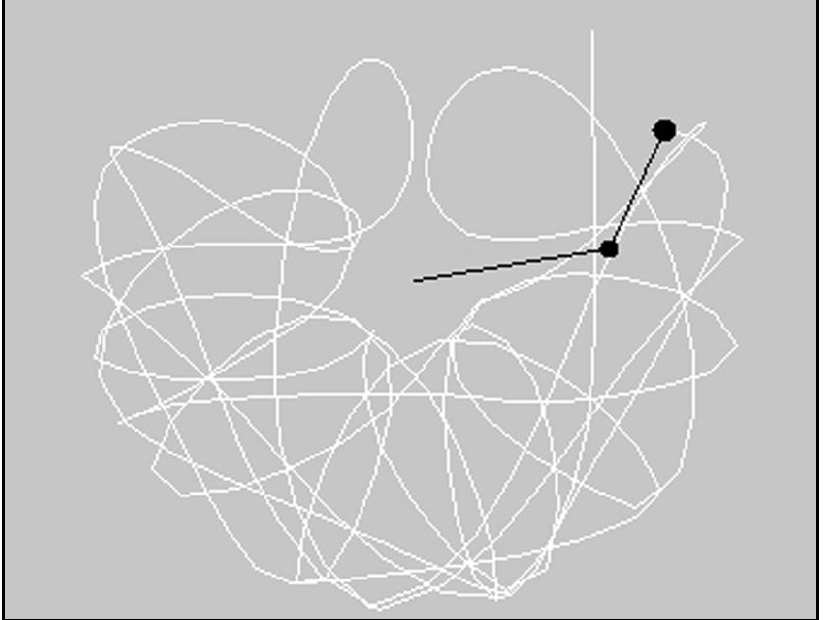
Figure 1. Double pendulum with canvas traces